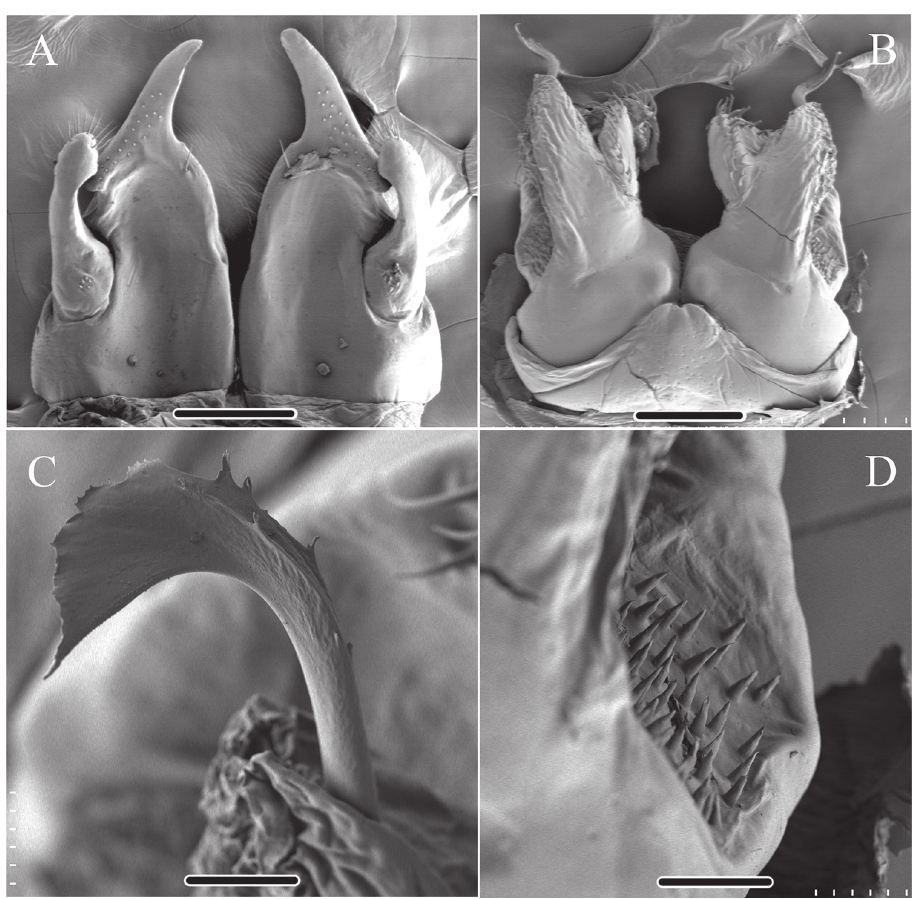
Figure 20. Glyphiulus impletus sp. n., paratype. A anterior gonopods, caudal view B posterior gonopods, caudal view C flagellum of posterior gonopods D microsetae at lateral margin of posterior gonopods. Scale bars: A 0.2 mm B 0.15 mm C, D 0.3